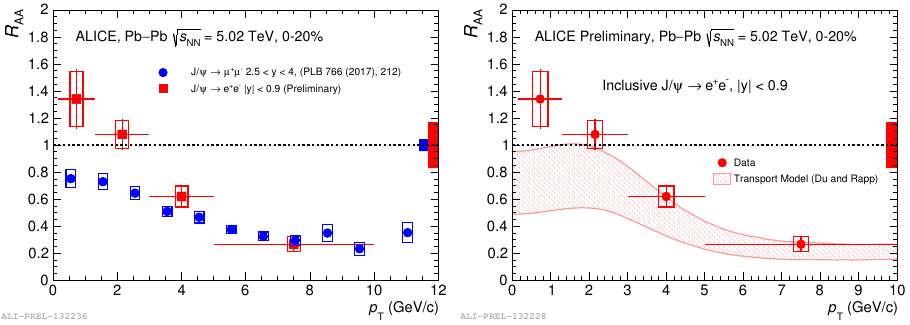
Figure 3. The nuclear modification factor measured in the 0–20 % centrality range compared to the forward measurement (left plot) and compared to a transport model prediction [16, 17] (right